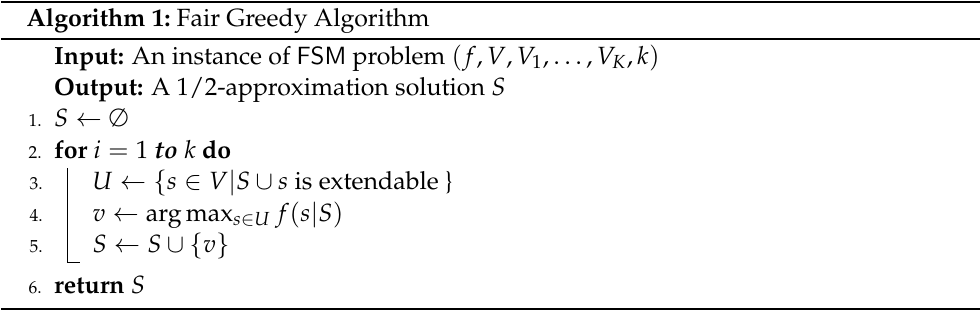
Algorithm 1: Fair Greedy